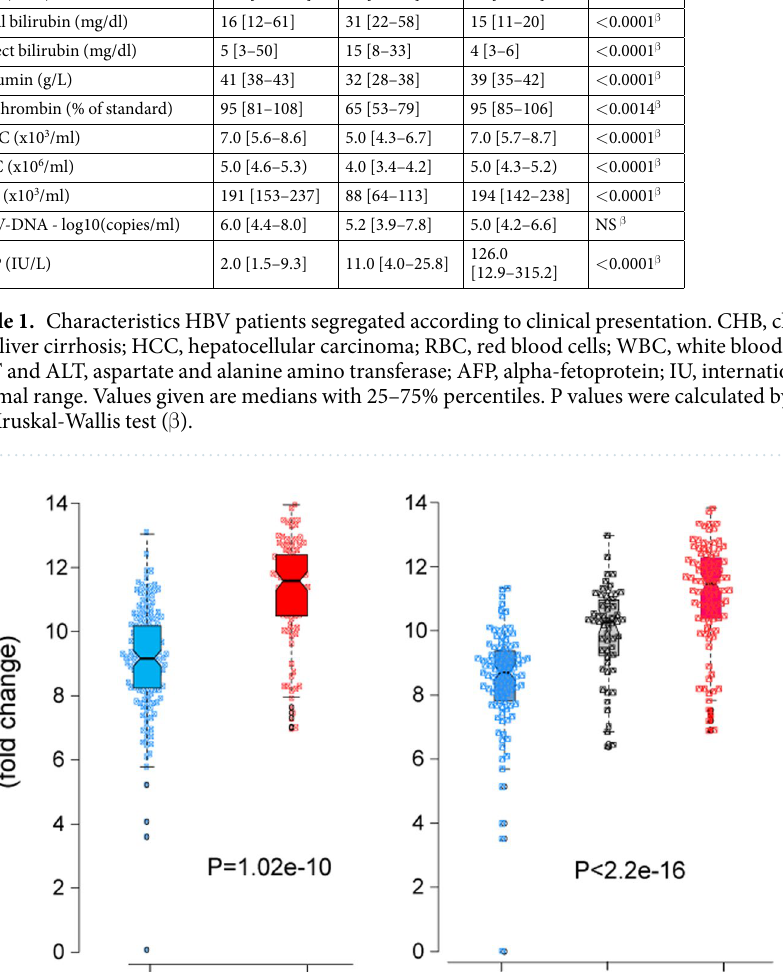
For identification of TERT C228T and C250T mutations, two allele-specific PCRs with individual forward primers: Tr-ARMS-TERT-MT(C228T)-F2: 5'-CCC CGG CCC AGC CCGT-3' and Tr-ARMS-C250T-MT-F: